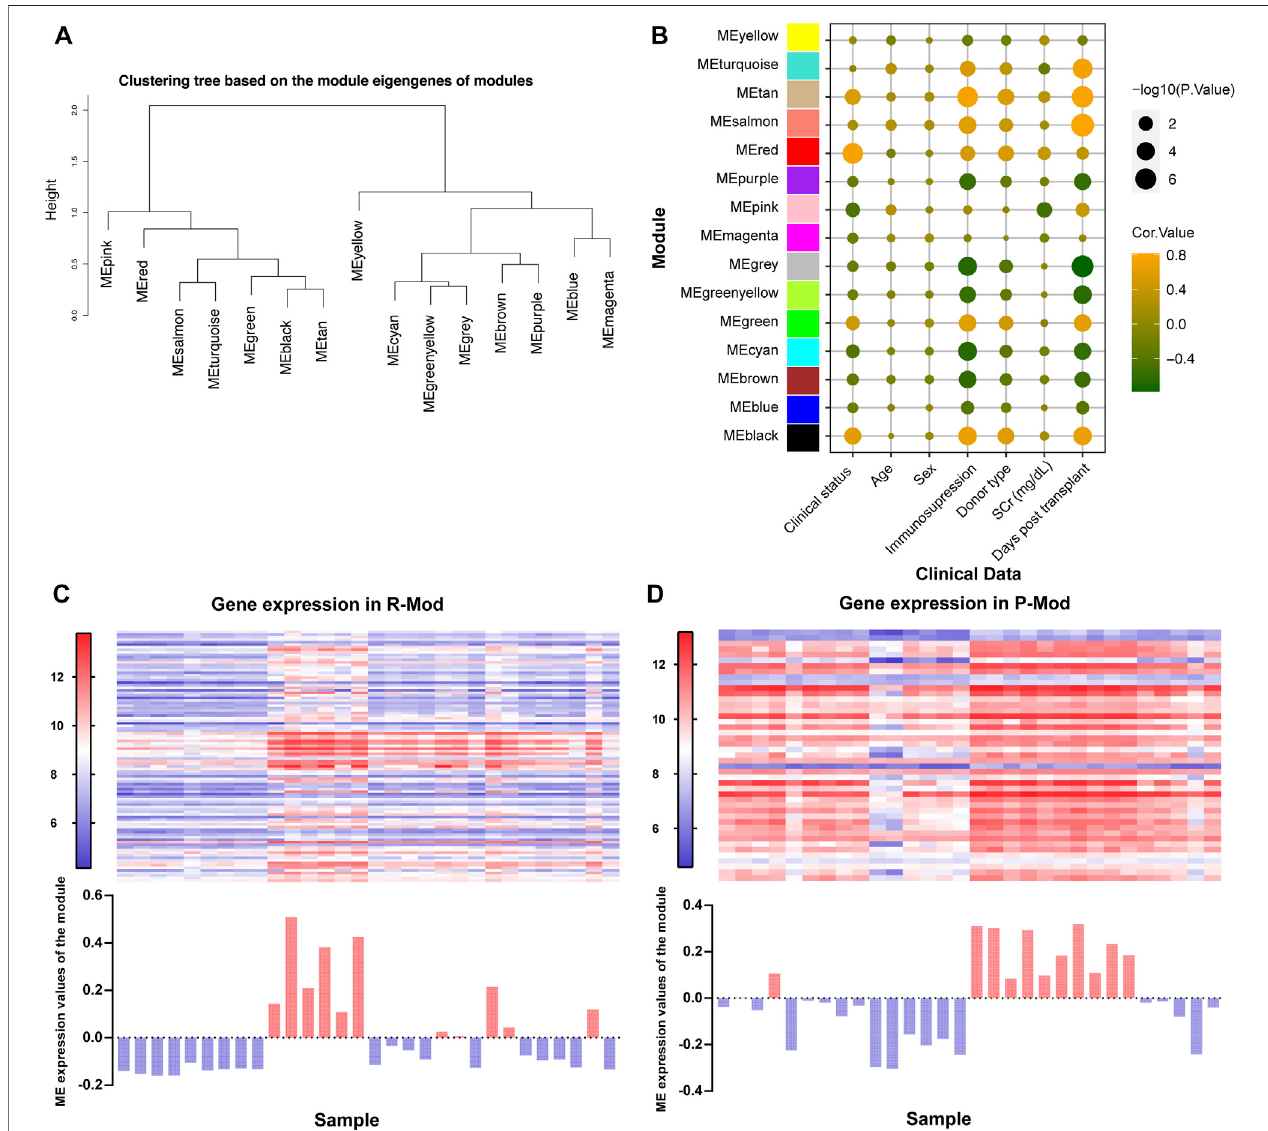
FIGURE 3 | Relationships between modules and clinical traits based on GSE1563. (A) Hierarchical clustering dendrogram of MEs. (B) Bubble plot of the association between the ME and clinical traits. The color represents the correlation coef fi cient, while the size shows the corresponding -log ( p -value). (C,D) Upper heatmap shows the expression levels of genes P-/R-Mod in each sample. The lower histogram shows the corresponding ME expression values of P-/R-Mod in each sample.